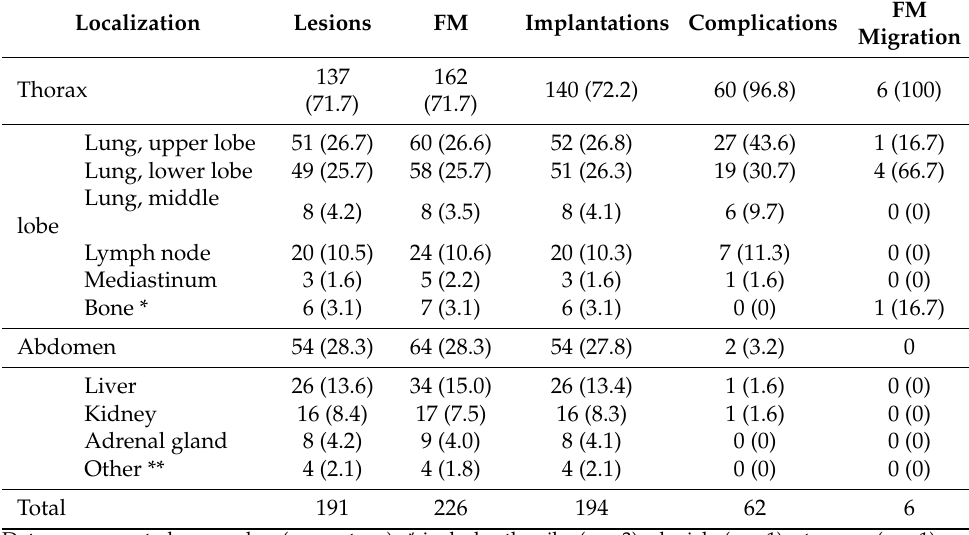
Table 3. Fiducial marker localization and complications in lesions that move with respiration using Synchrony tracking.